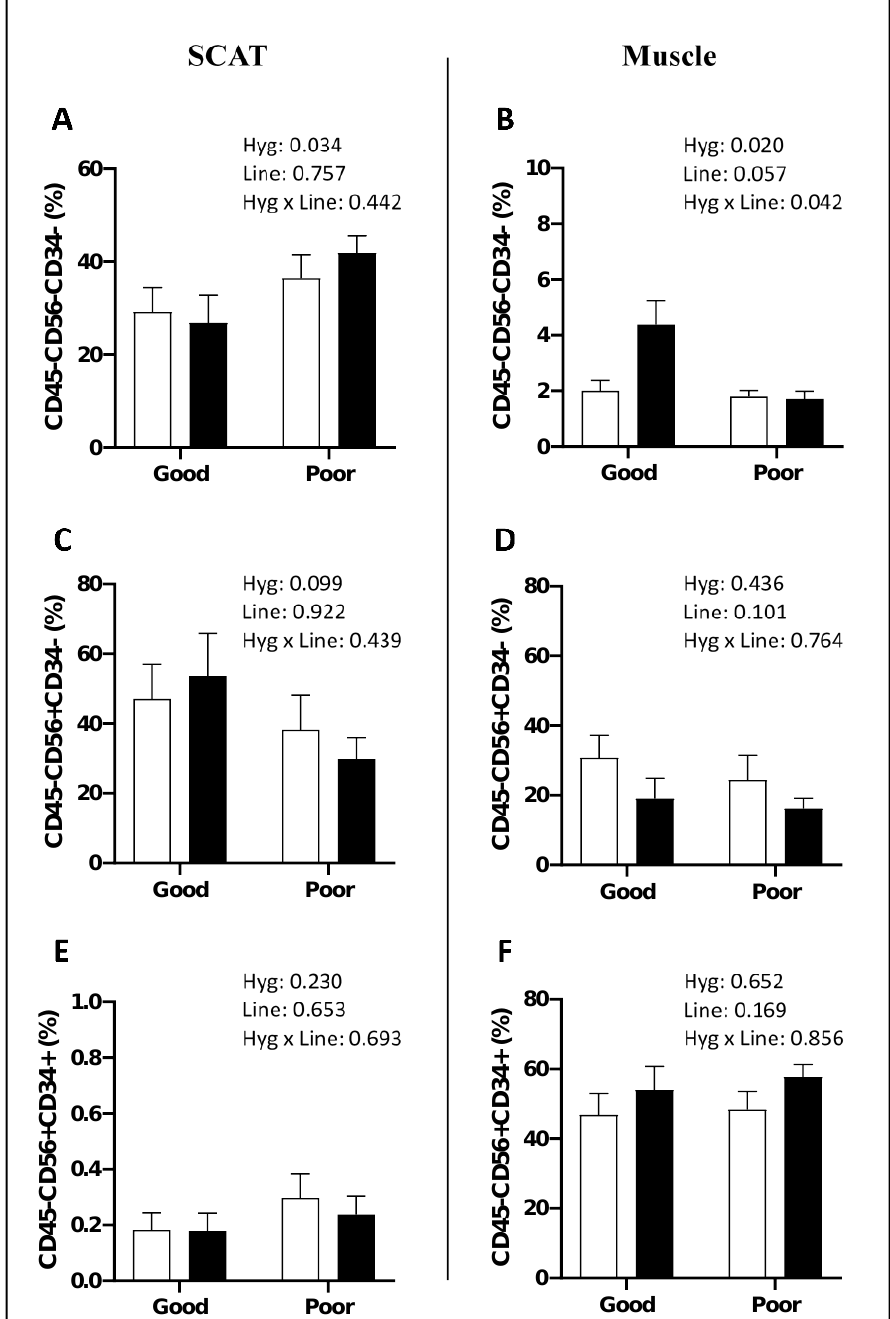
Figure 4. Percentage of mesenchymal stromal/stem cell populations in subcutaneous adipose tissue (SCAT) and longissimus muscle from low (LRFI, black bar) and high (HRFI, white bar) residual feed intake pigs housed in good or poor hygiene conditions. Percentage of cell populations are expressed as means ± SEM (n= 5-9/experimental